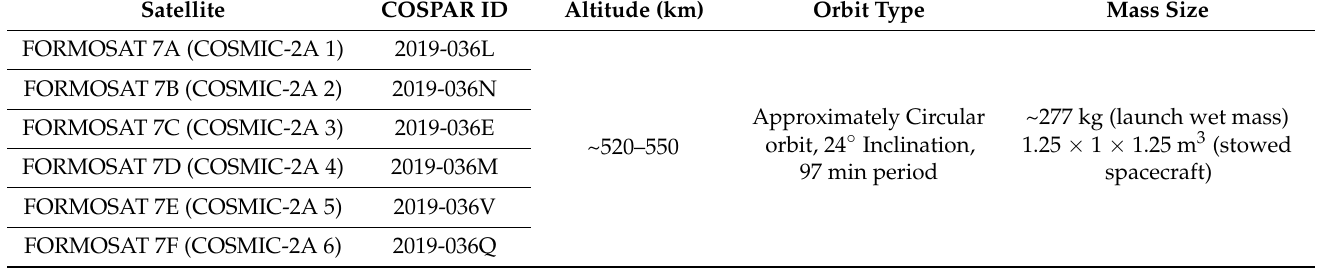
Table 7. COSMIC-2 satellite specifications (the ESA Earth Observation Portal (eoPortal)).